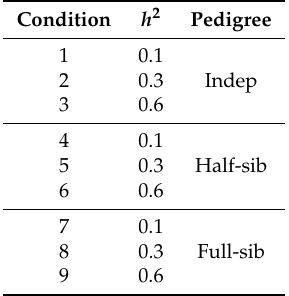
Figure 1. Schematic diagram to summarize the procedure for improving a randomized complete block (RCB) design. Table 1. Simulation conditions for the motivating example assuming a spatial correlation ρ = 0.6 and ( 30 ) ( 196 ) ( 30 ) ( 30 ) a nugget error of 0.1 for the three designs: Ω , Ω and Ω , where Ω represents an RCB D A A A design with 30 treatments (genotypes) arranged in 6 blocks of sizes 5 rows by 6 columns and optimized using an A -optimality criterion. Initial m = 1000 designs were generated and the overall best design (design with smallest trace under A -optimality or largest determinant under D -optimality) selected to be optimized. The algorithm was stopped after p = 20,000 iterations. Final designs for each condition represented the improved design and the ODE % are calculated using Equations (1) and (2). Each of the nine conditions was repeated λ = 10 times for all four algorithms: SP, GP4, GP14 and SA. Condition h 2